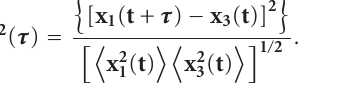
system is not a pure function of state error, especially when the feedback control is a linear states